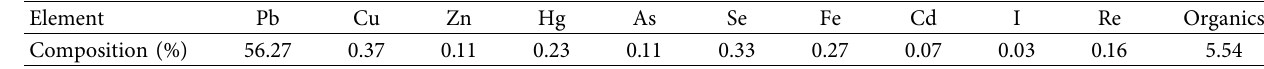
Table 1: Te chemical composition of lead